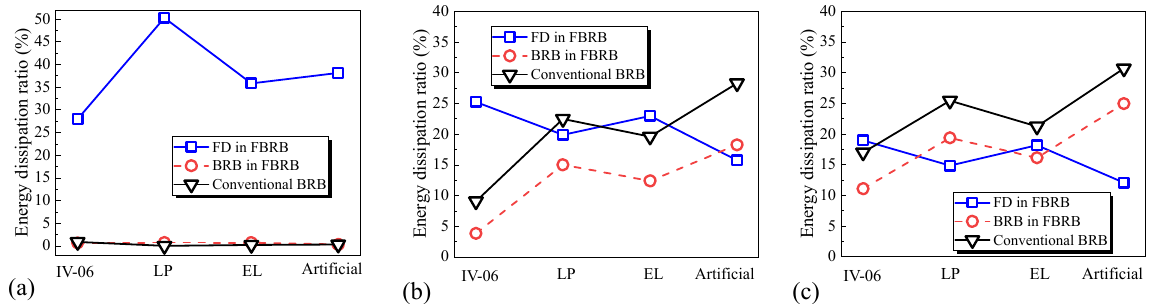
Figure 19. Energy‑dissipation ratio of the brace: ( a ) PGA = 70 cm/s 2 ; ( b ) PGA = 400 cm/s 2 ; and ( c ) PGA = 620 cm/s 2 .